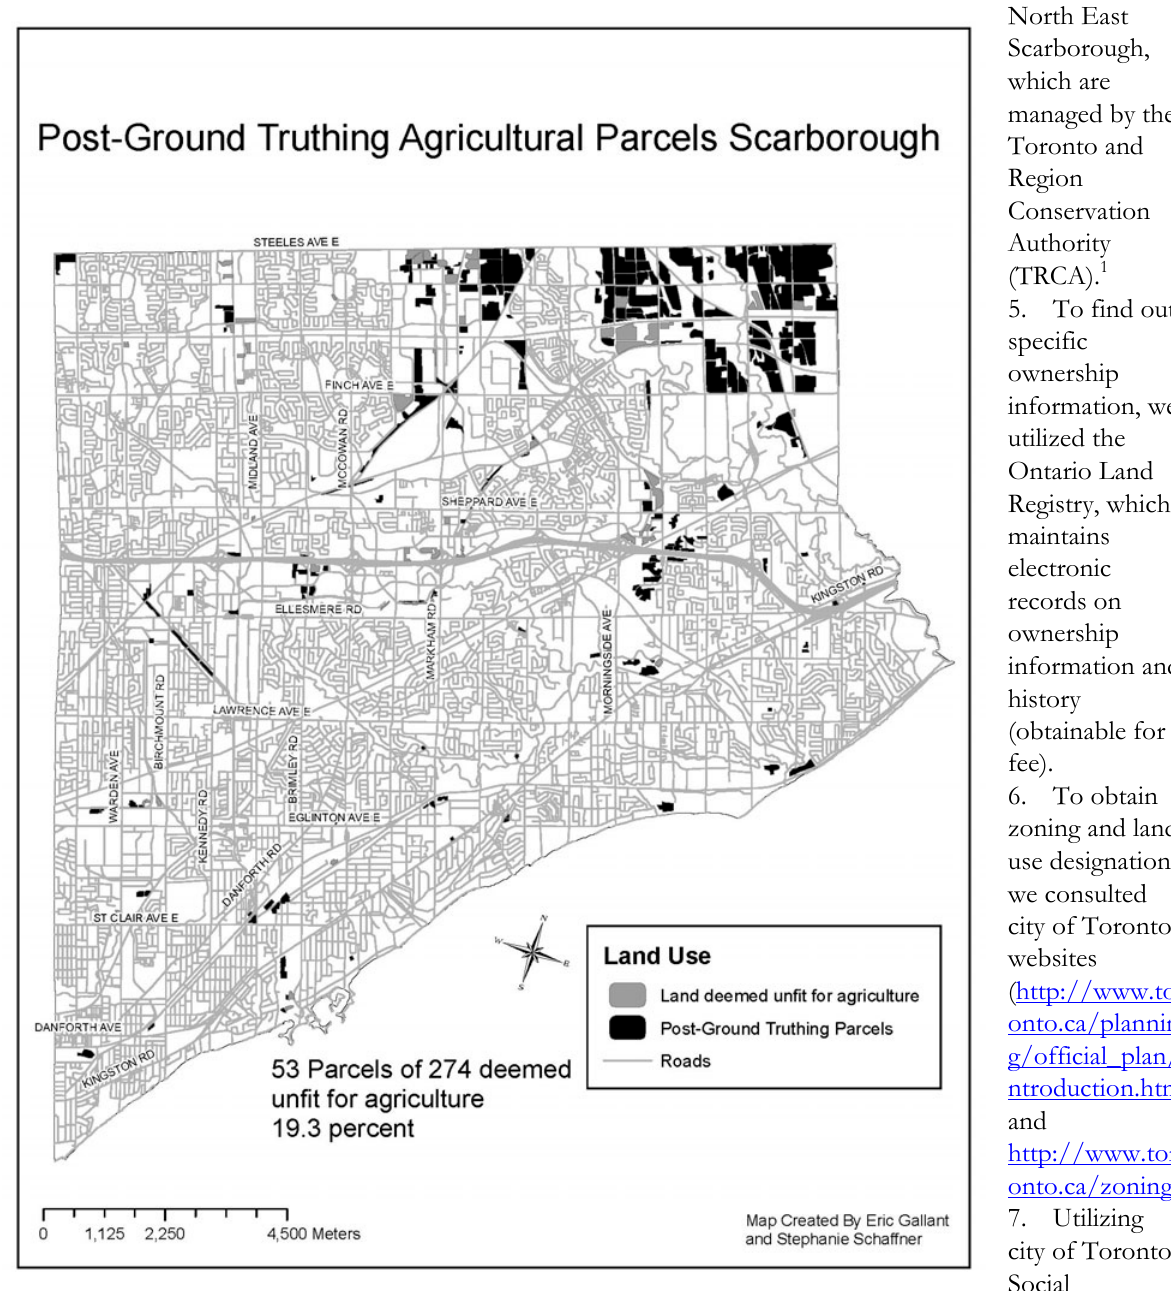
Figure 2. Post-Ground Truthing Agricultural Parcels in